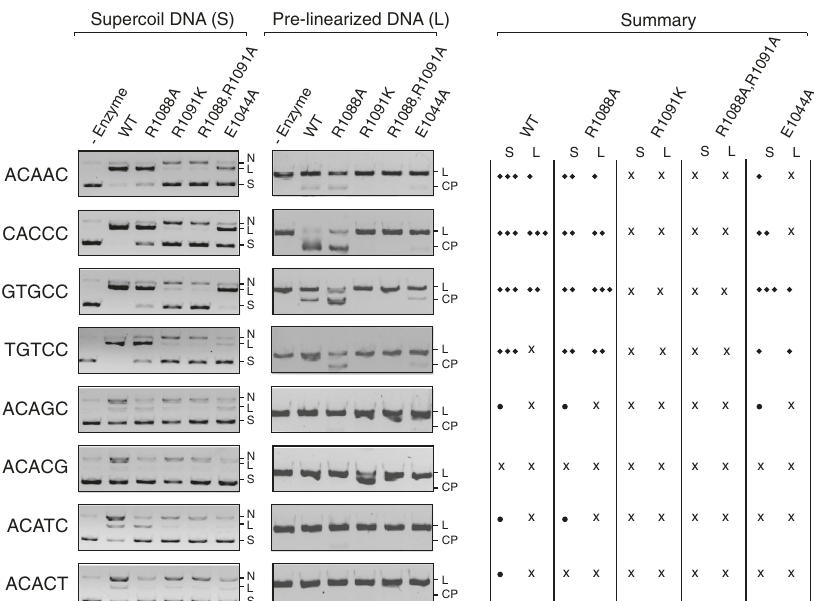
Fig. 5 Protospacer-associated motif (PAM) recognition by AceCas9 mutants. In vitro cleavage of the supercoil and pre-linearized plasmid substrates with different PAMs by the wild type and mutant AceCas9. “ L ” denotes linearized product DNA, “ S ” denotes the supercoil DNA substrate, “ N ” denotes nicked DNA, and “ CP ” denotes cleaved product. Each DNA substrate at 6 nM concentration was incubated with 1 μ M AceCas9 or its mutants at 50 °C for 15 min followed by gel separation and ethidium bromide staining. The intensity of each reaction product was estimated and summarized in the summary table where the number of fi lled circles indicates the activity level and “ x ” indicates non-detectable activity. The DNA cleavage experiments were repeated more than three times with similar results. Original images of this fi gure are provided in Supplementary Fig. S5 with DNA markers.